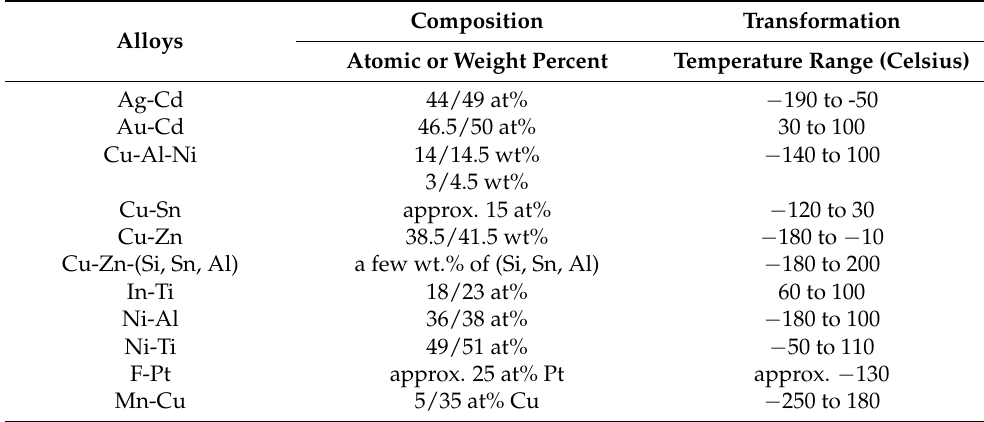
Table 2. Alloys with a memory effect of